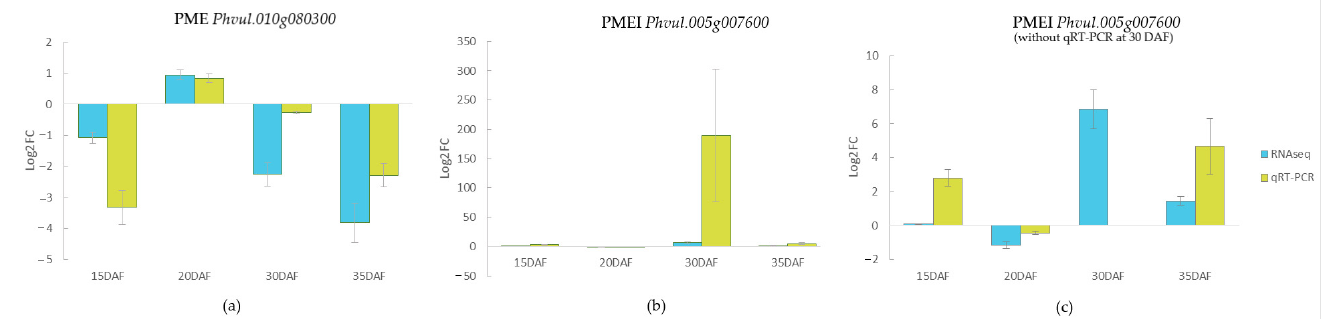
Figure 5. Bar plots showing a gene expression comparison in selected genes encoding ( a ) a pectin methyl-esterase (PME) Phvul.010g080300 and ( b ) a pectin methyl-esterase inhibitor (PMEI) Phvul.005g007600 in an RNA sequencing and qRT-PCR experiment. The gene expression of PMEI Phvul.005g007600 excluding the qRT-PCR gene expression visualization at 30 DAF is shown in ( c ). Gene expression is shown in log2 fold-change values (Log2FC) in the slow-cooking Pinto bean (treatment sample) when compared to the fast-cooking Rosecoco bean (control sample) with β -tubulin as the housekeeping gene [53]. Error bars represent the standard error within samples.